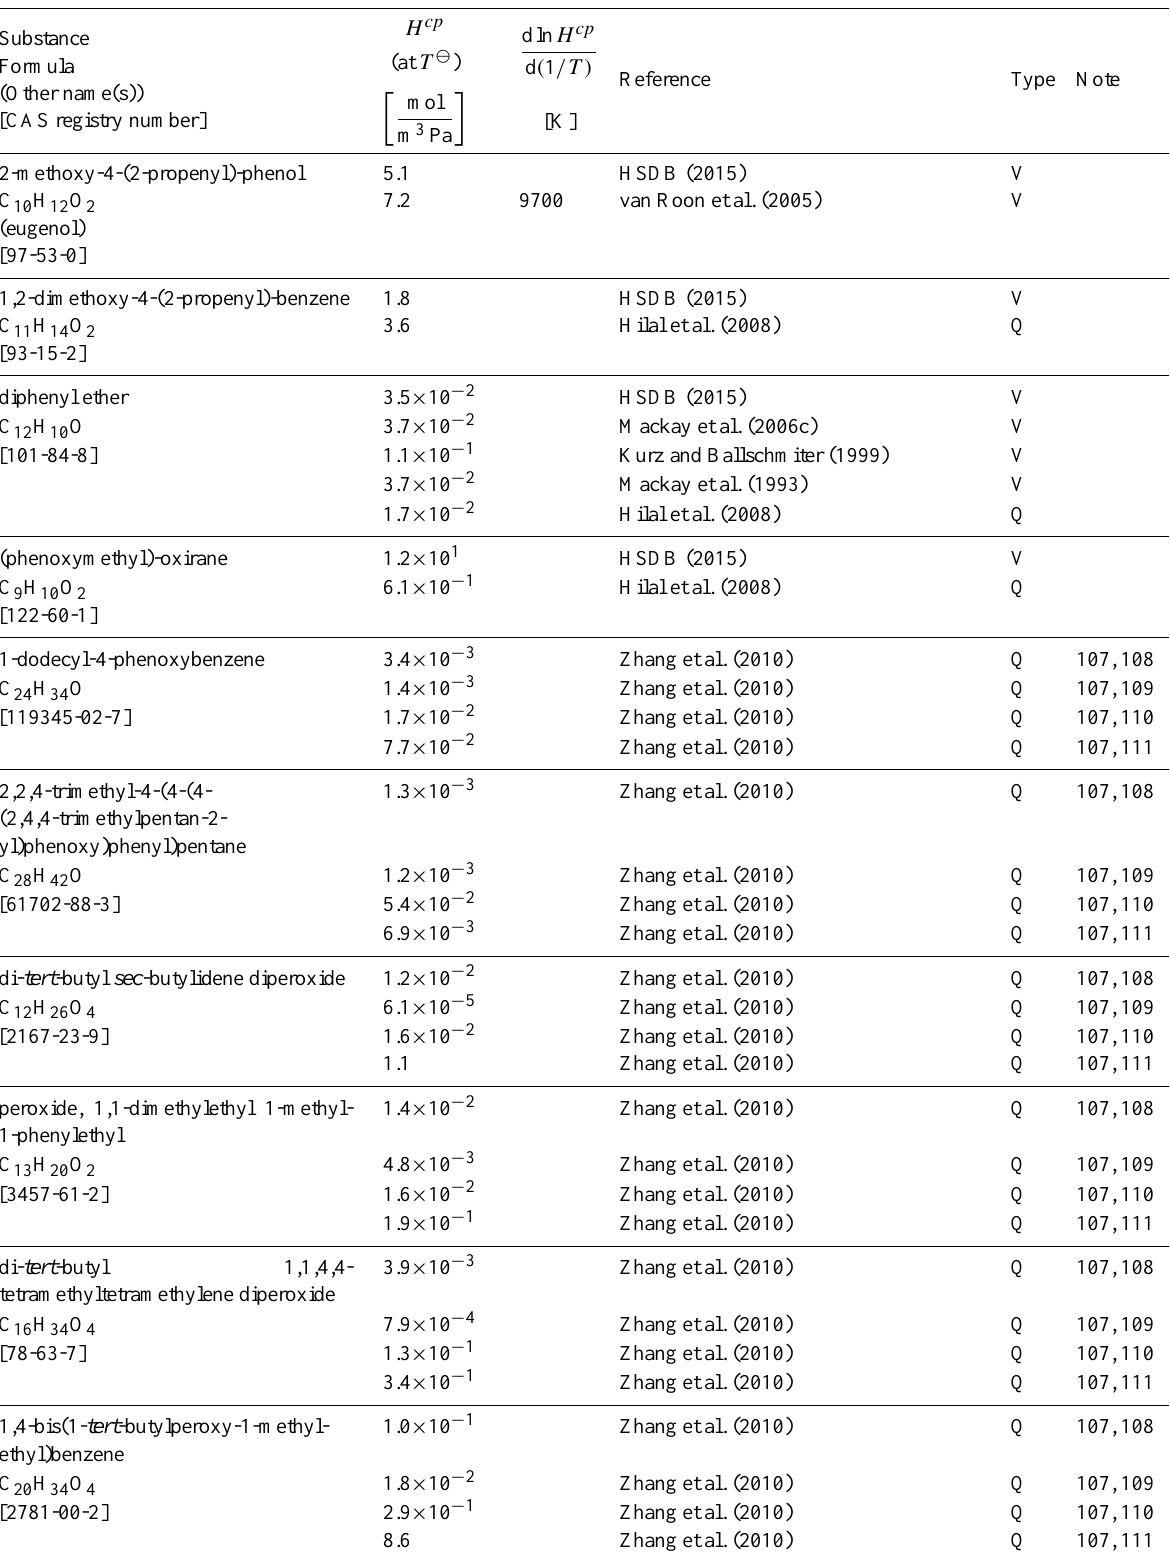
Table 6: Henry’s law constants for water as solvent